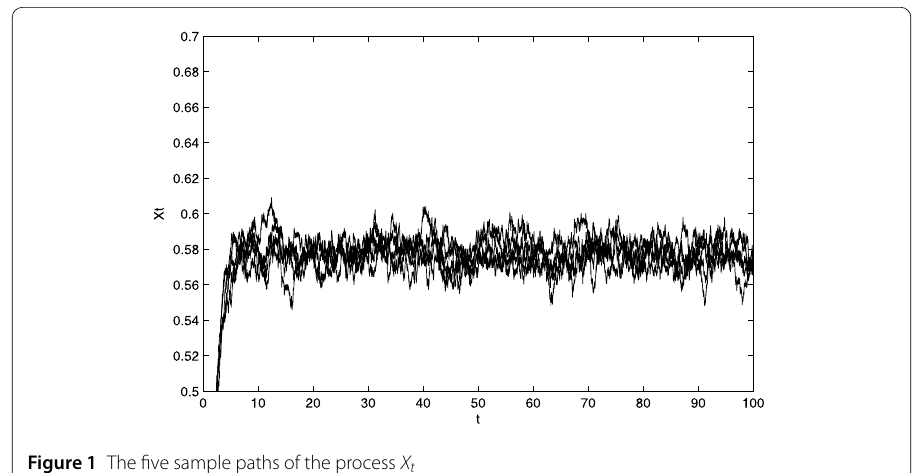
Figure 1 The five sample paths of the process X t